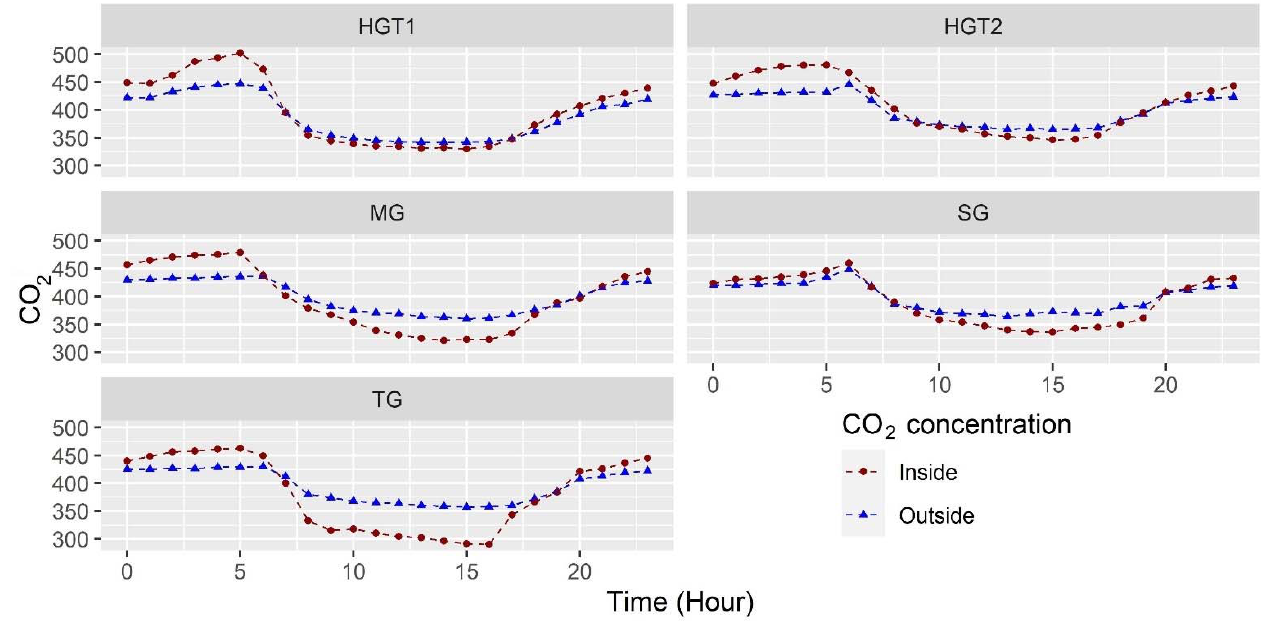
Figure 4. Mean radiation behavior for the sensor in the indoor environment and mean outdoor radiation solar for each of the greenhouses evaluated.